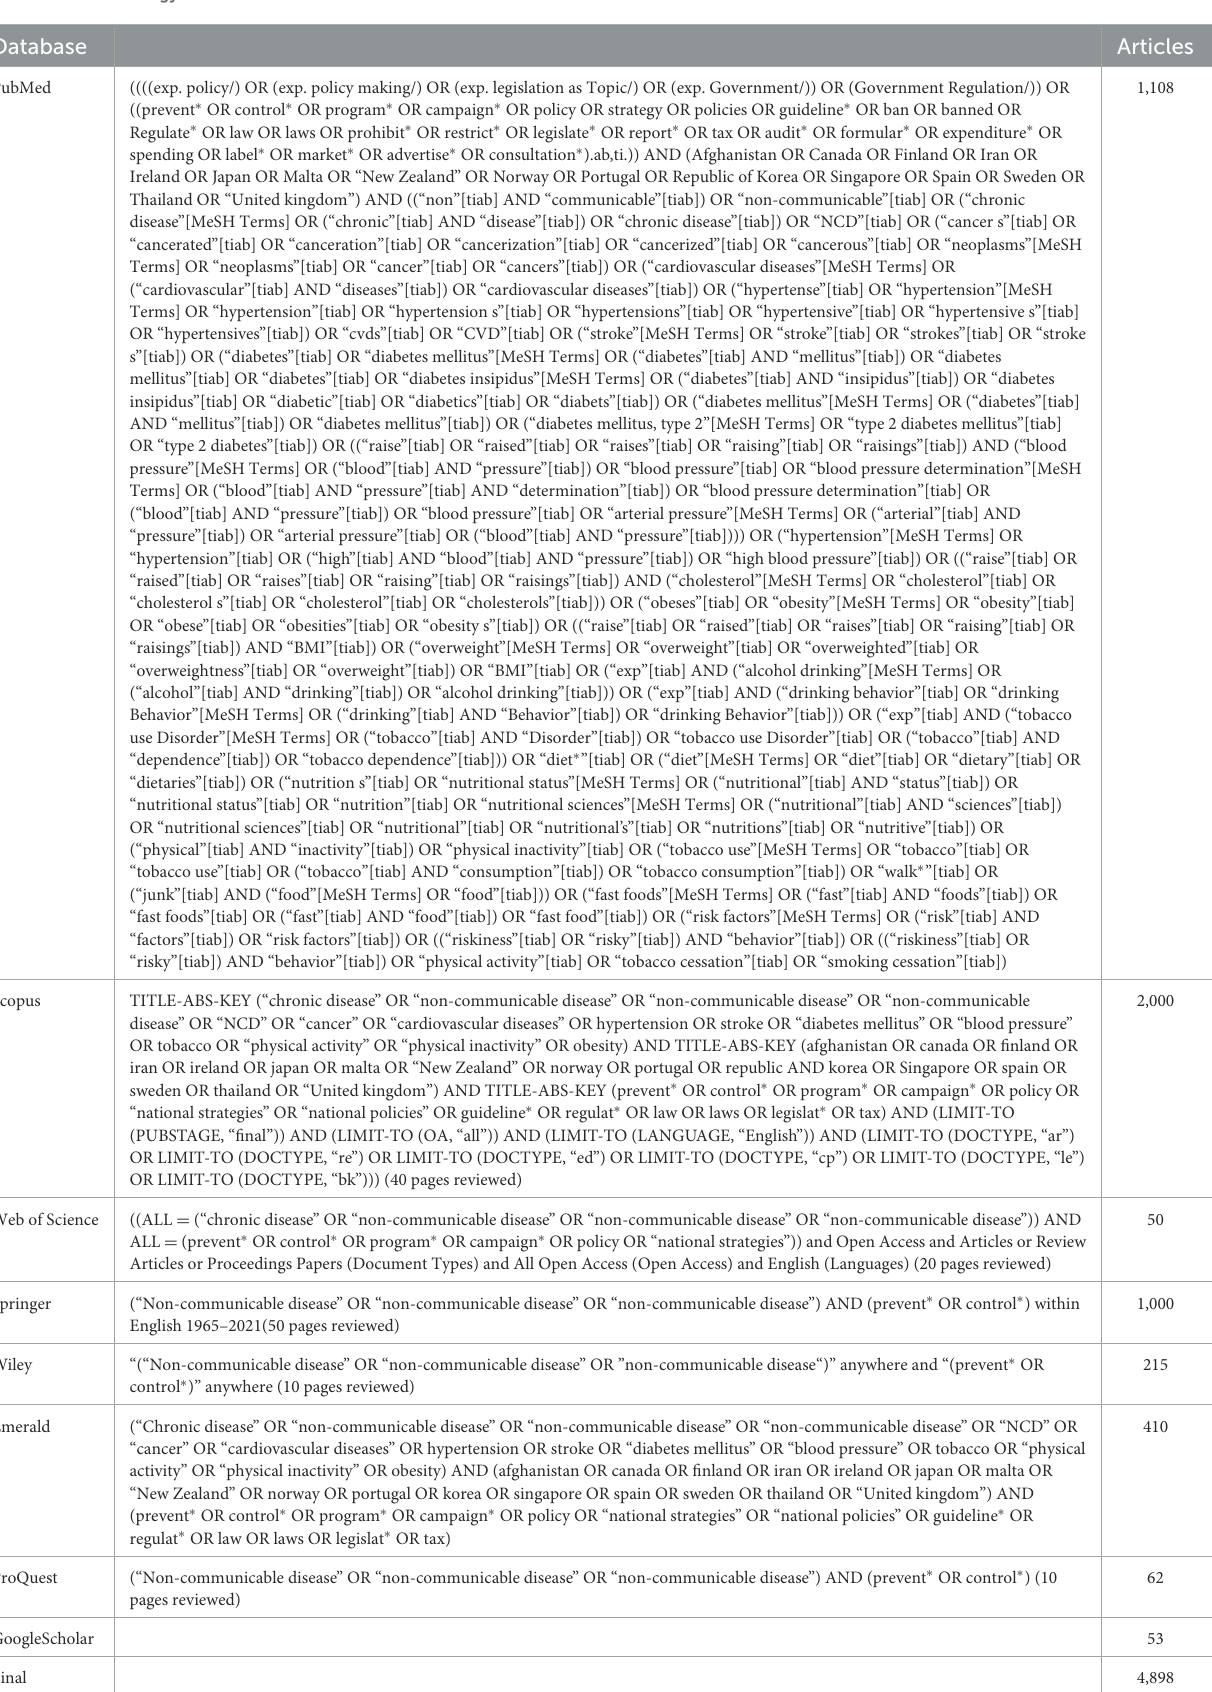
TABLE 1 Search strategy terms in selected